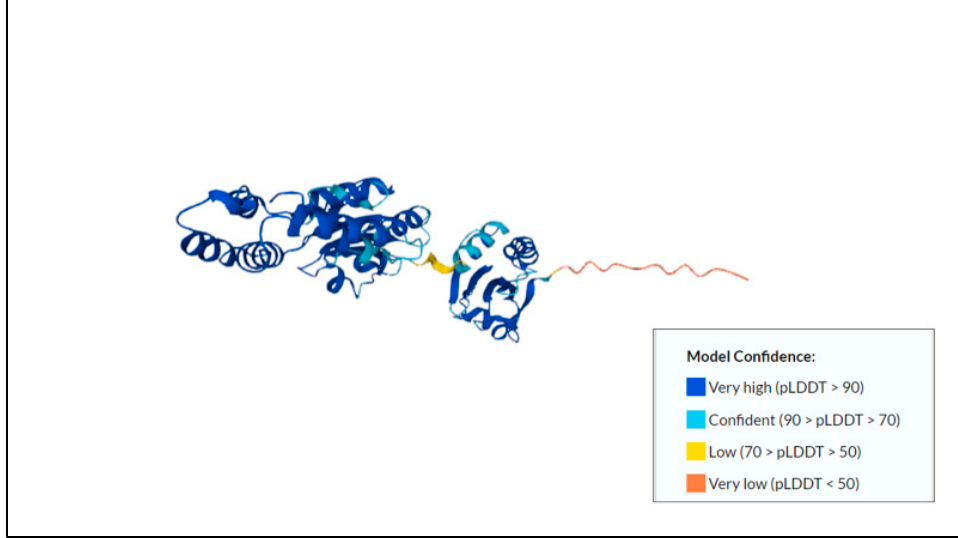
Figure 3. Predicted protein structure of protein disulfide isomerase [41,62,63] (https://www.uniprot.org/uniprotkb/A0A5K1UZD0/entry, accessed on 25 October 2022).